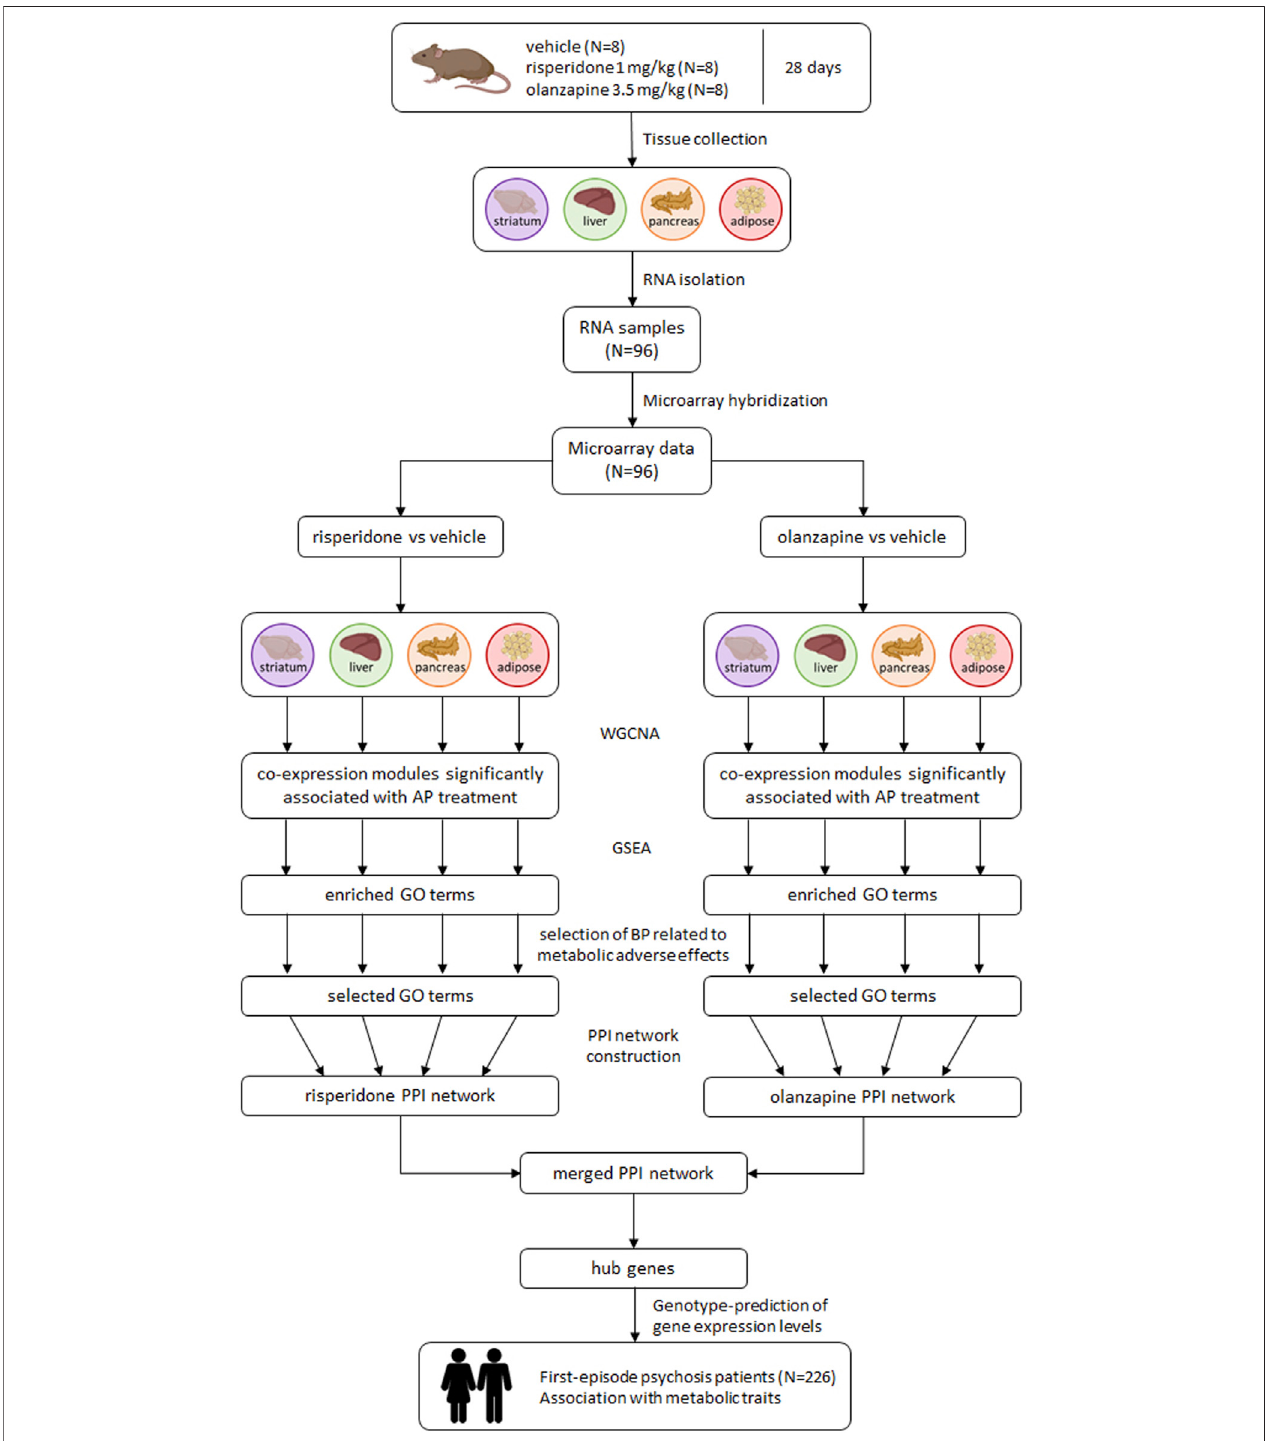
FIGURE1| Overviewoftheanalysisprocedurefollowedinthestudy.AP:antipsychotic;BP:biologicalprocesses;GO:GeneOntology;GSEA:genesetenrichment analysis; PPI: protein-protein interaction; WGCNA: weighted gene co-expression network analysis.